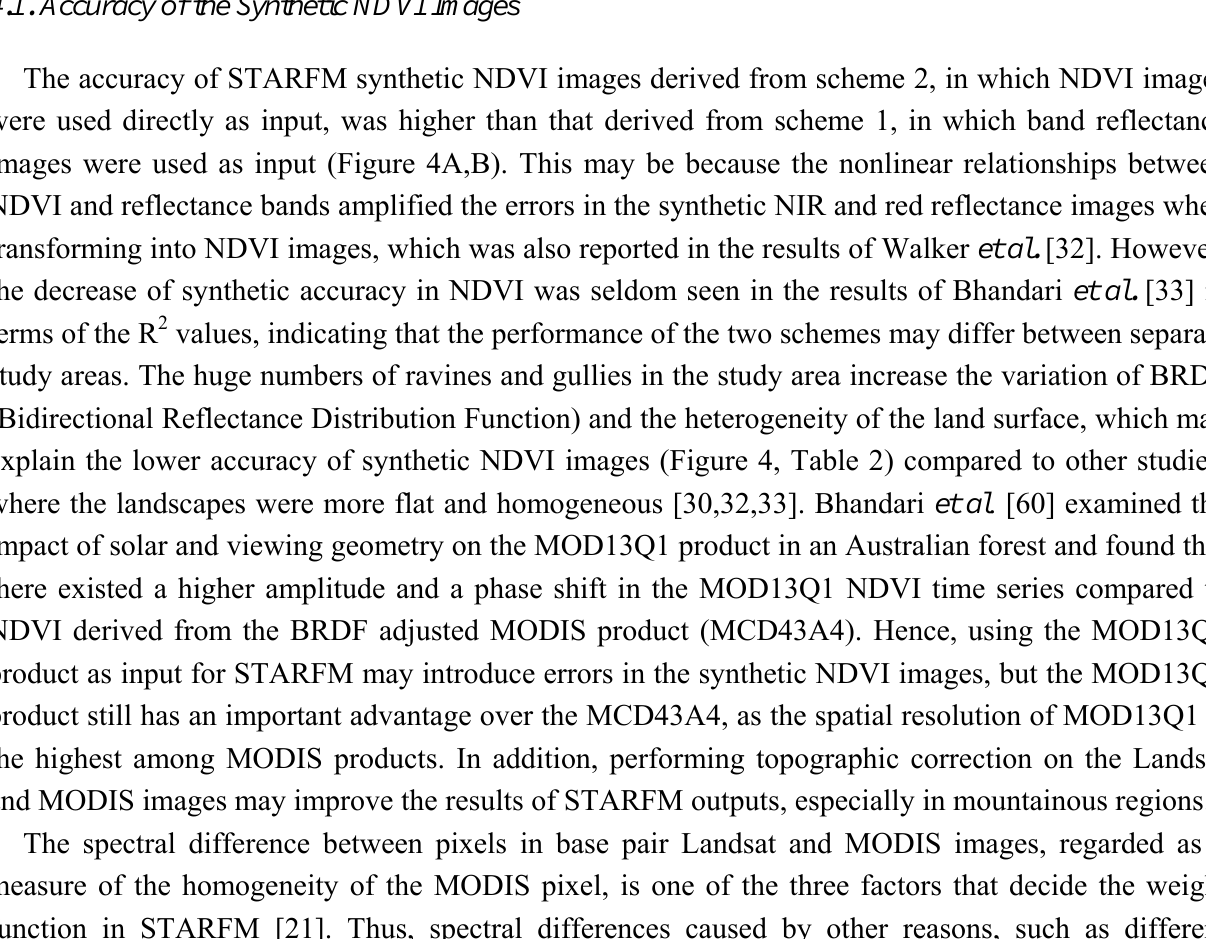
trends derived from the max